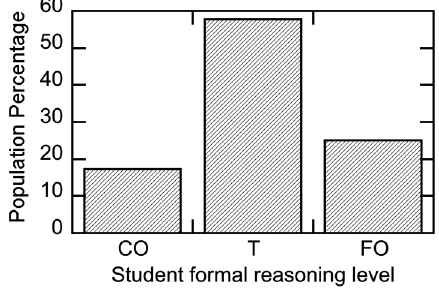
FIG. 1. Distribution of formal reasoning level for non-STEM students enrolled in conceptual physics or astronomy. Formal reasoning level was determined by the LCTSR. Concrete opera- tional (CO), transitional (T), and formal operational (FO) rea- soning levels are